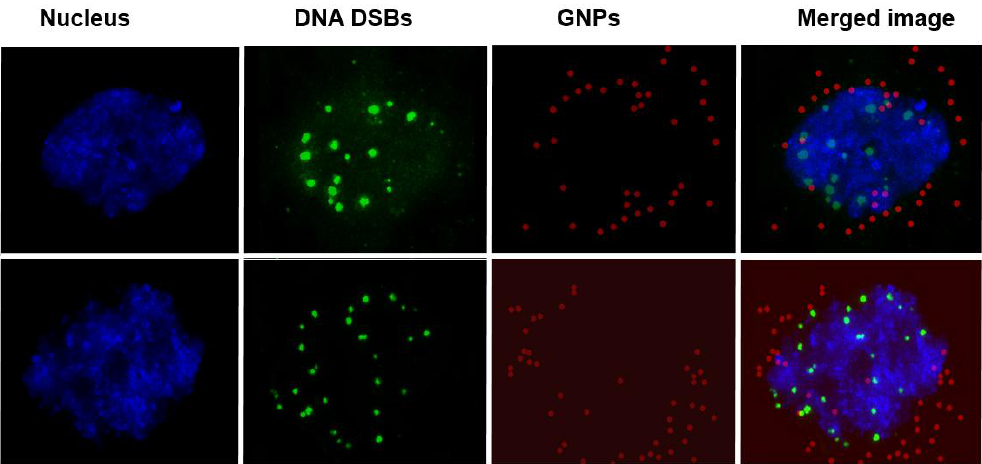
Figure 9. Hyperspectral mapping of GNP distribution and DNA DSBs in cells incubated with the GNP-BLM complex. More NPs were seen either in the nucleus or closer to the nuclear membrane. The clinical efficacy of the BLM is thought to stem from their ability to mediate single- and double-strand DNA breaks [49,50]. However, it appears that DSBs are the most lethal ones causing cytotoxicity after interaction of BLM with DNA [38]. Hence, we probed the extent of DNA DSBs as a tool to determine the therapeutic efficacy of GNP-BLMs vs. BLM (see Figure 5). It has shown previously that the immobilization of BLM on glass beads via covalent linkage through the C- terminal substituent has little effect on the ability of BLM to cleave DNA [51]. One unrepaired DNB is sufficient to trigger permanent growth arrest and lead to cell death [38]. As illustrated in Figures 5